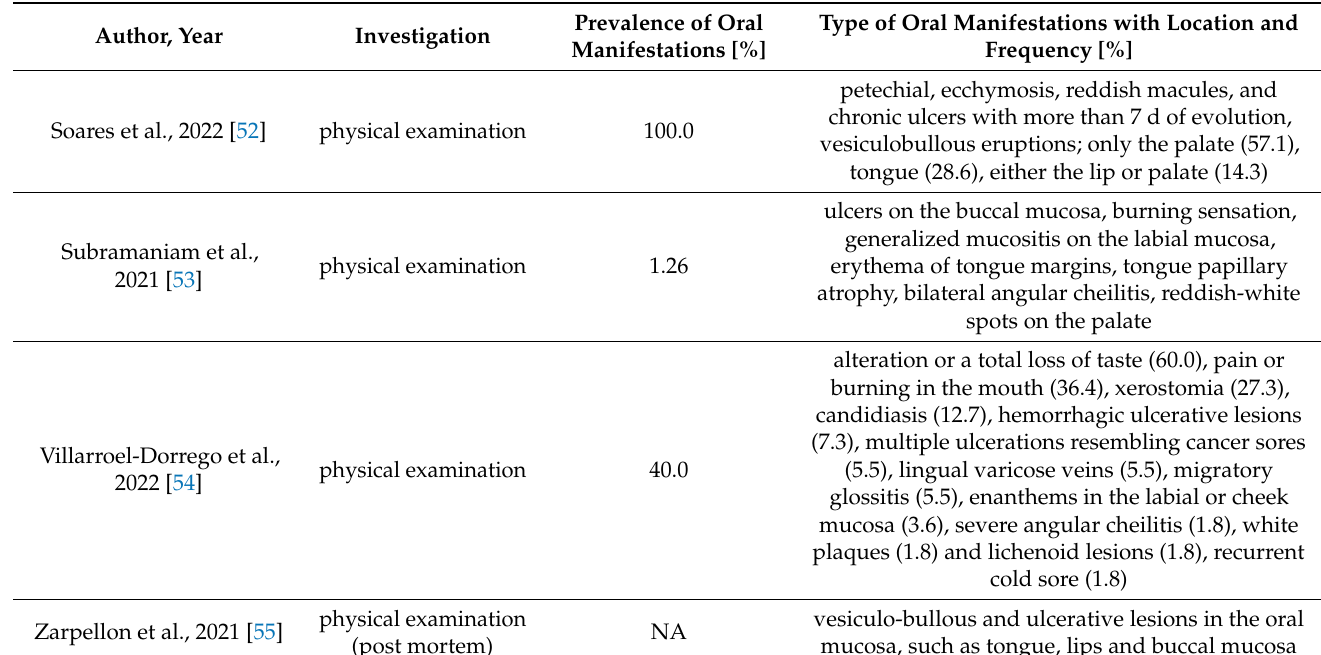
Figure 4. Forest plot presenting the summarized prevalence of xerostomia among SARS ‐ CoV ‐ 2 positive individuals.